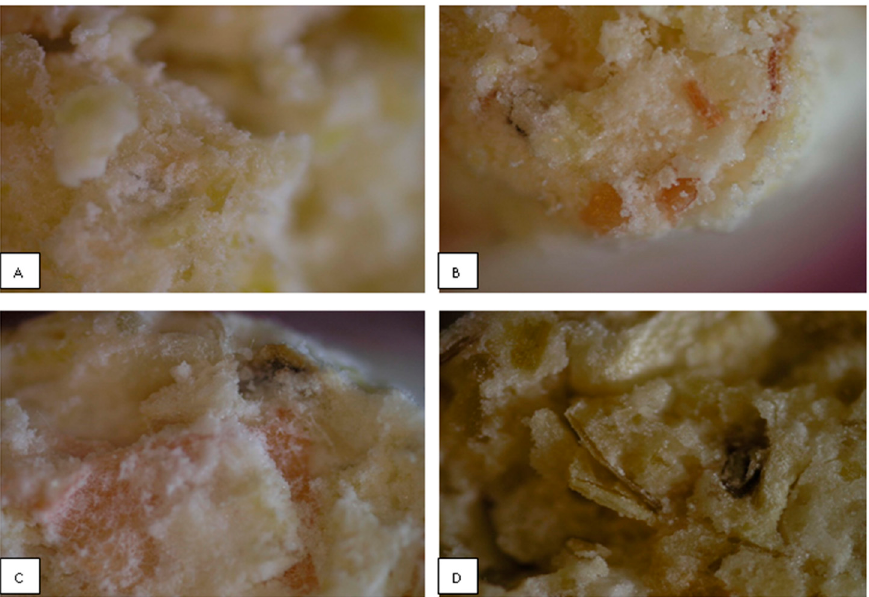
Figure 10. Microscopic pictures of pelleted corn bran: ( A ) 20% moisture level, ( B ) 25% moisture level, ( C ) 30% moisture level and ( D ) 35% moisture level.